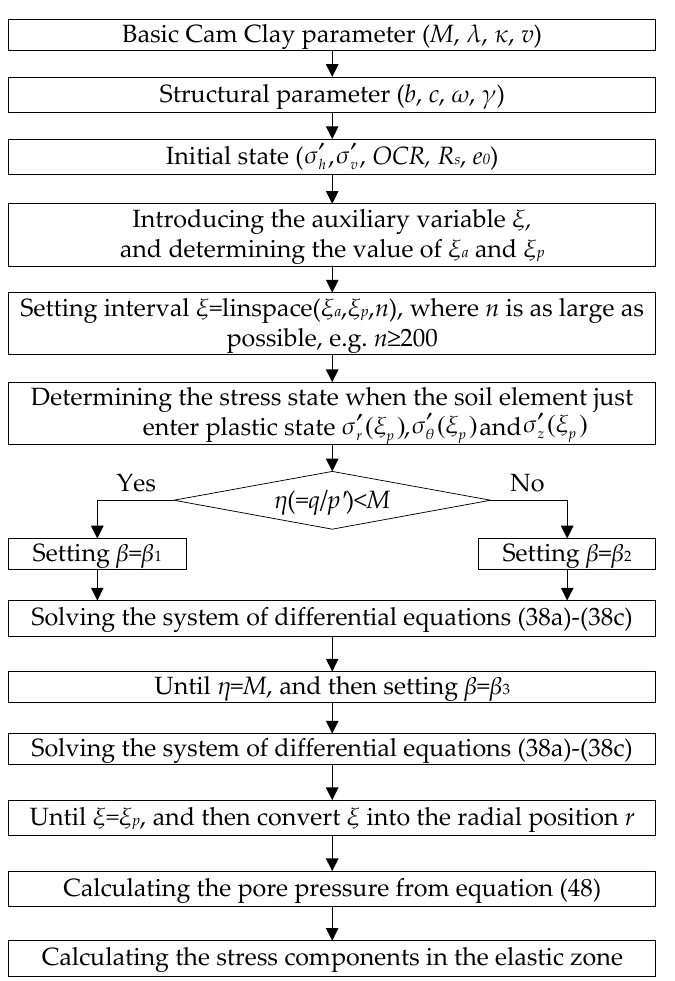
Figure 5. The flowchart for solving the cavity expansion problem using the present solution.